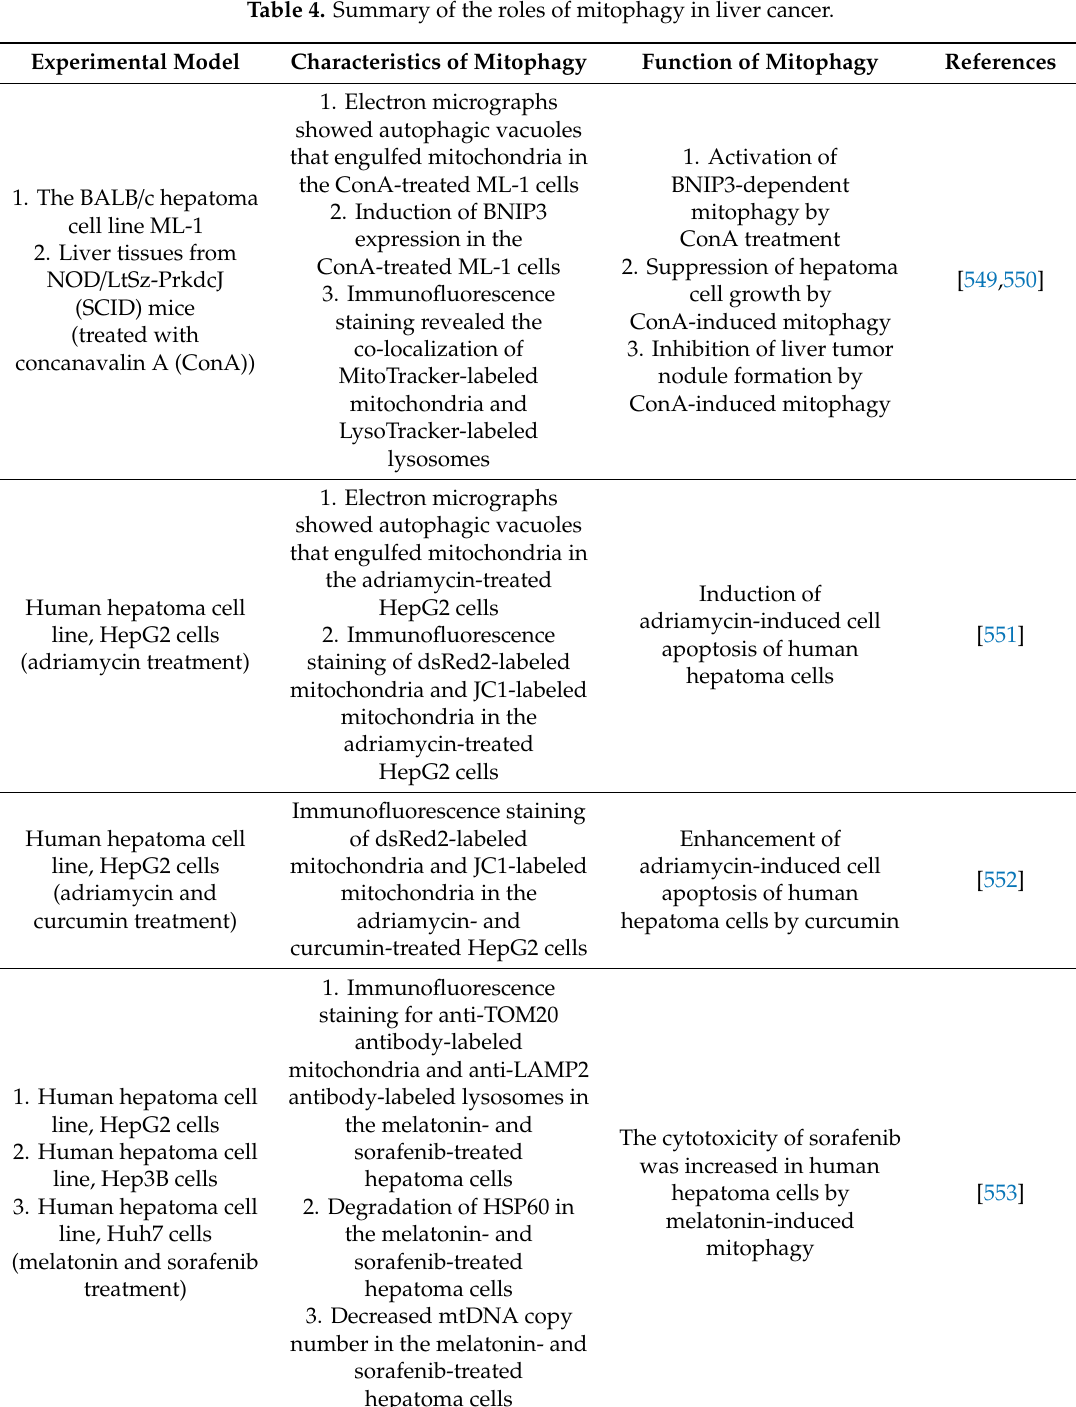
Table 4. Summary of the roles of mitophagy in liver